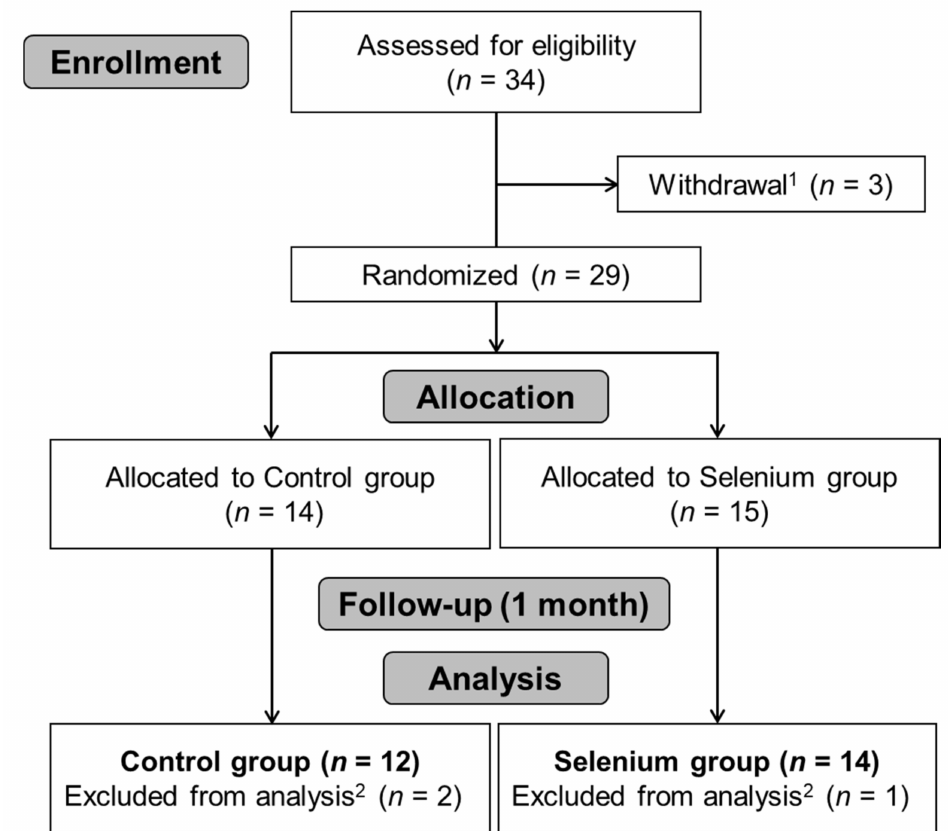
Figure 1. Flowchart describing progress during a randomized, placebo-controlled trial of selenium supplementation. 1 Three participants declined to participate in the study for personal reasons unrelated to the intervention (fracture, influenza, and transportation problems). 2 Outliers were excluded from the final analysis. CTRL: control; SE: